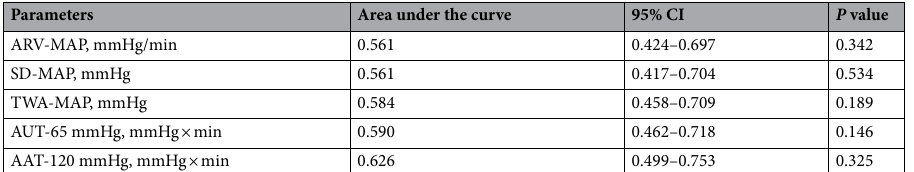
Table 5. Area under the receiver operating characteristic curve of each mean arterial pressure parameter for predicting postoperative acute kidney injury. CI confidence interval, ARV average real variability, SD standard deviation, TWA time-weighted average, MAP mean arterial pressure, AUT area under threshold, AAT area above